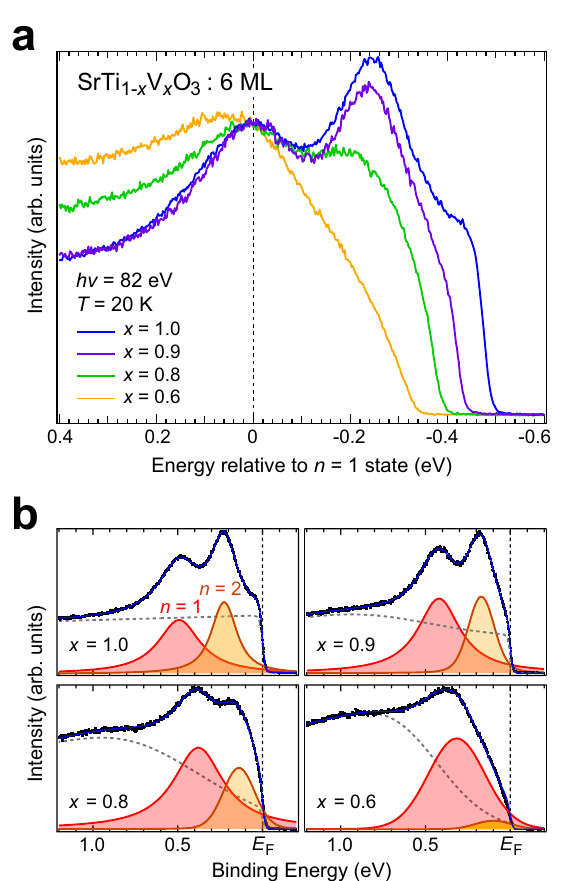
Fig. 2 Quantitative analysis for QW states in λ -controlled STVO QWs. a ARPES spectra at the Γ point for STVO QWs. The data are the same as the EDCs shown in Fig. 1, but are plotted aligned at the peak position of n = 1. b Line-shape analysis of the EDCs for STVO QW states. The EDCs have been fi tted to a combination of two Voigt functions corresponding to n = 1 (red hatched) and n = 2 (orange hatched) with a smooth background (dashed line), multiplied by the Fermi-Dirac function.